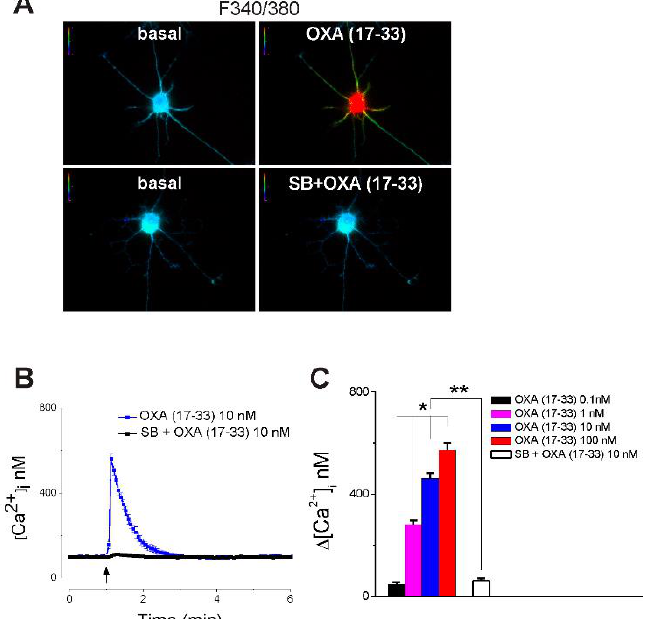
Figure 1. OXA (17-33) increases cytosolic Ca 2+ concentration, [Ca 2+ ] i , in nucleus accumbens